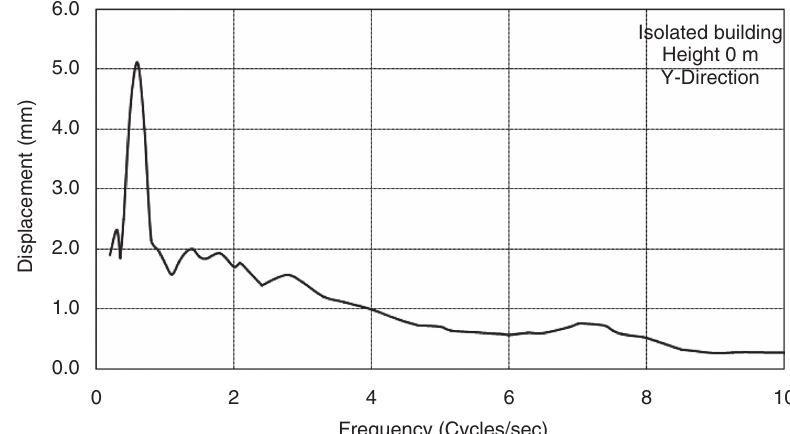
Fig. 19. Spectral Displacement in Y-direction (isolated building)